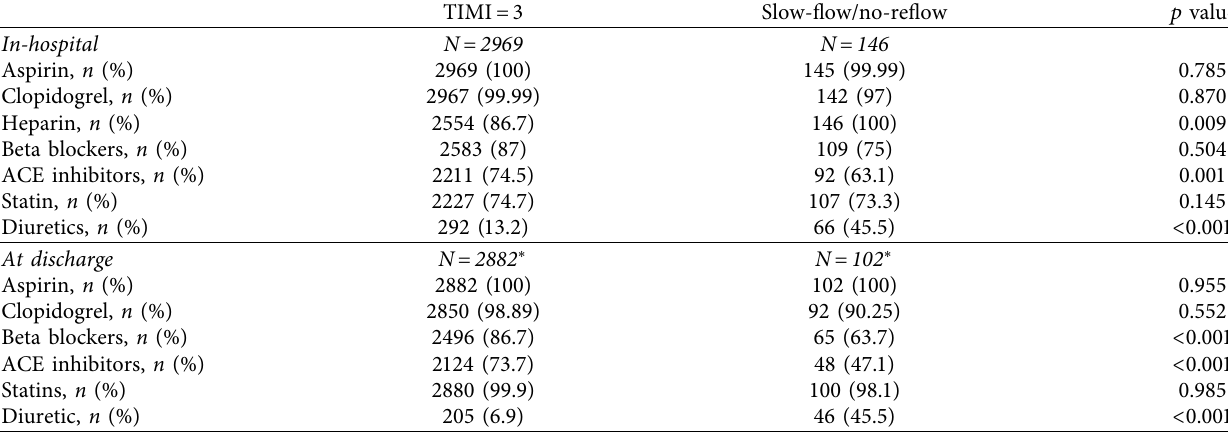
Table 2: Terapy during hospitalization and at discharge from hospital.